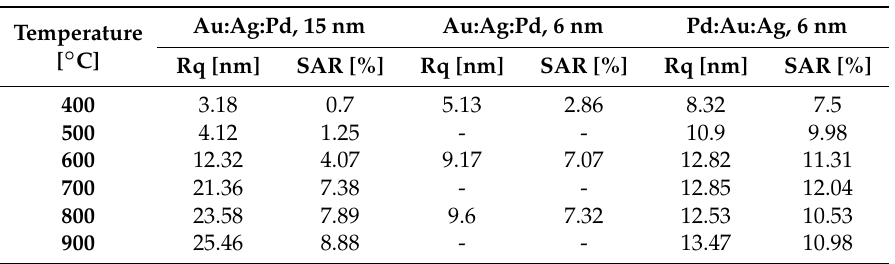
Table A1. Summary of roughness (Rq), surface area ratio (SAR) of the samples with various deposition amount, composition, and annealing temperature.